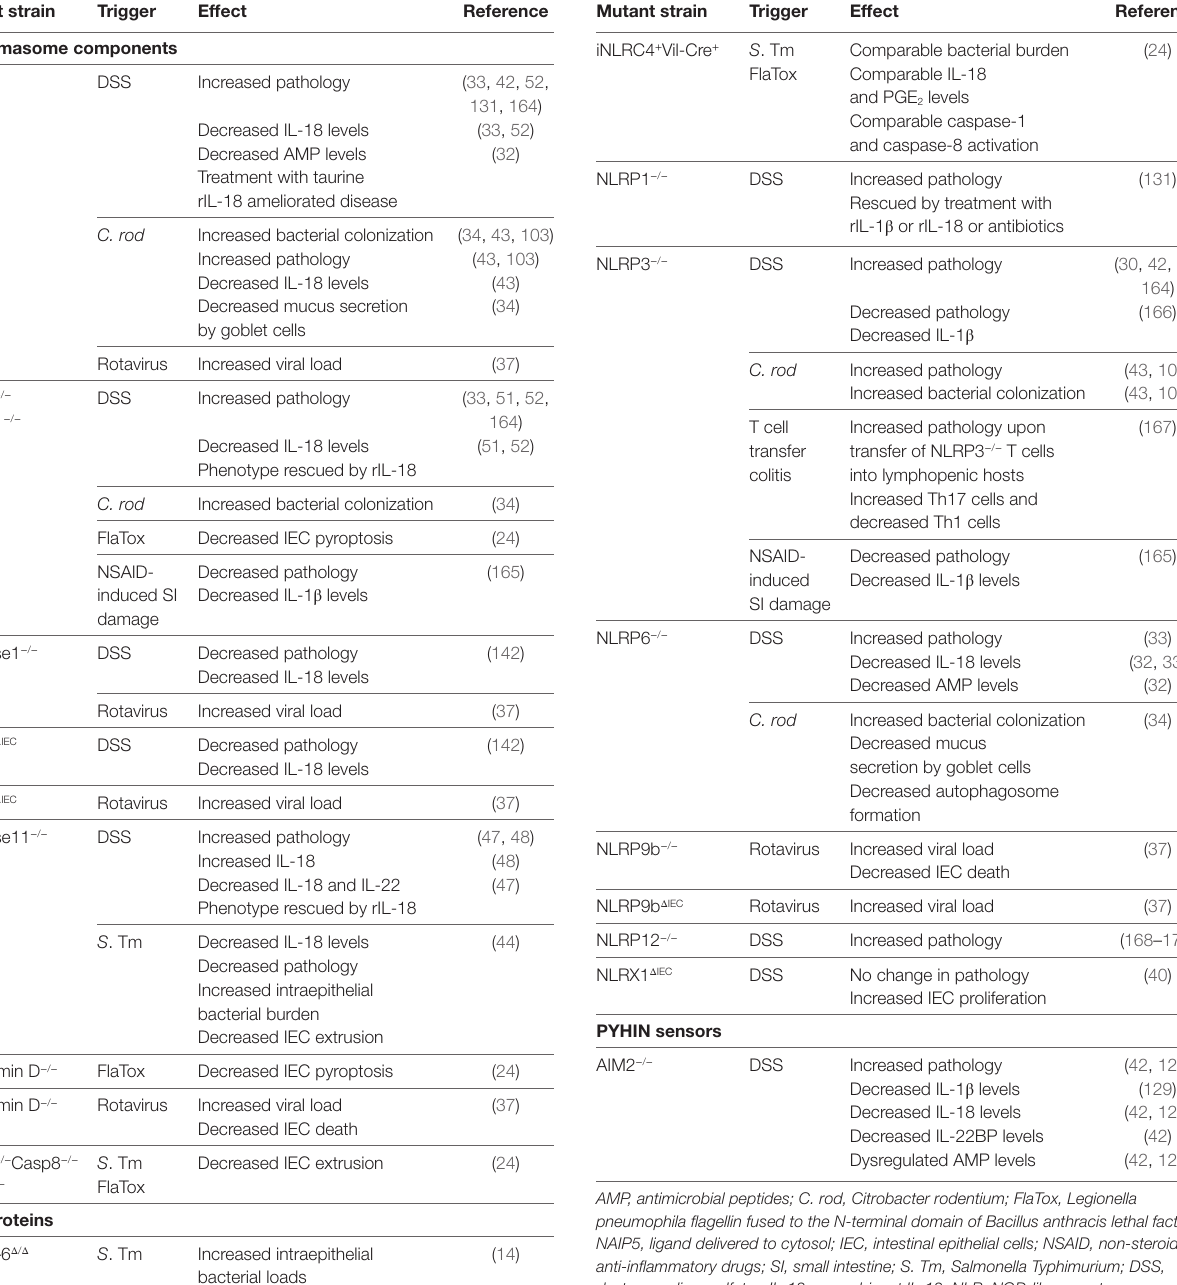
TabLe 2 | Inflammasome components and intestinal